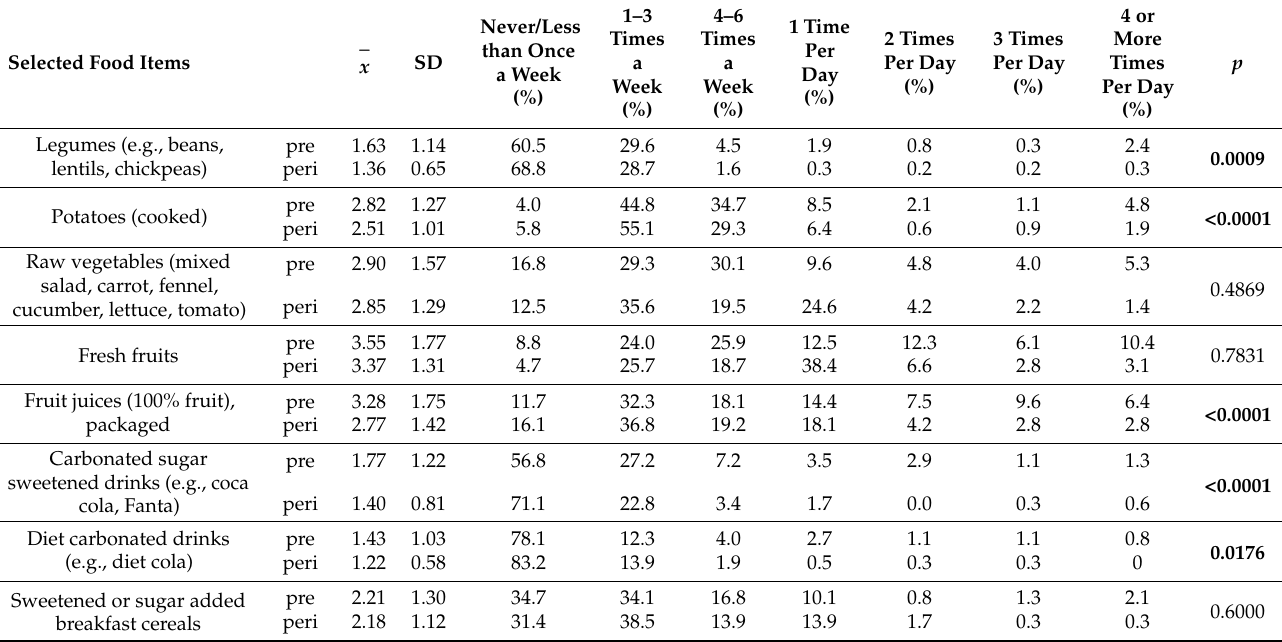
Table 3. Differences in frequency of food intake between children before and during the